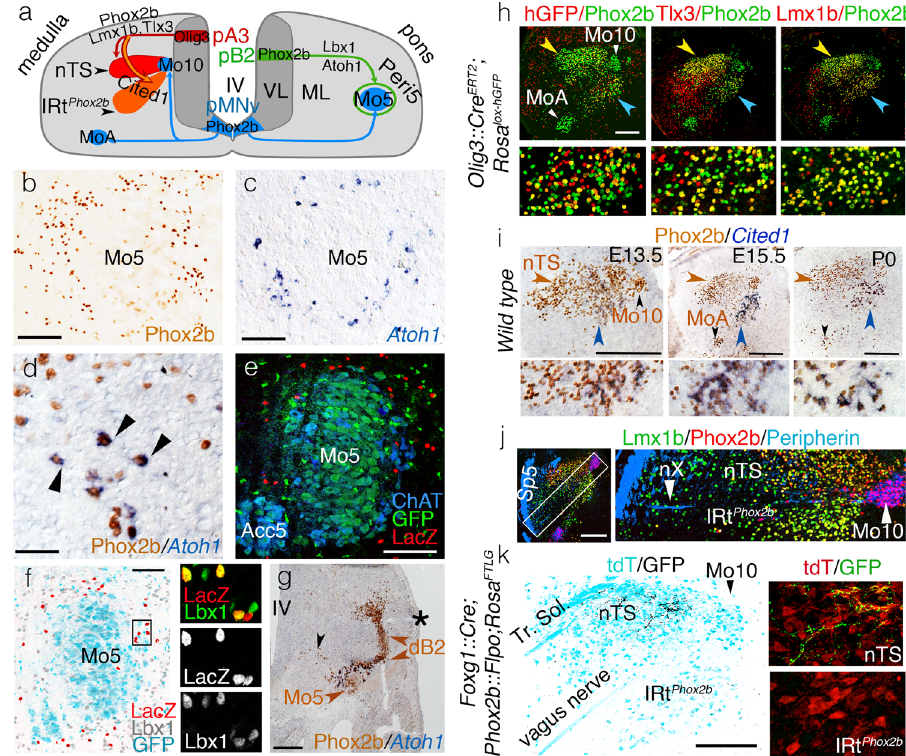
Fig. 2 Ontogenetic de fi nition of IRt Phox2b and Peri5 Atoh1 . a Two schematic hemisections of the embryonic medulla (left) or pons (right), showing the origin of branchiomotor nuclei (Mo5, MoA, and Mo10), Peri5 Phox2b and IRt Phox2b in progenitor (p) domains of the ventricular layer (VL), their settling sites in the mantle layer (ML), and their transcriptional codes. b – d Coronal sections through the pons at E18.5, showing Peri5 Phox2b ( b ) or Peri5 Atoh1 ( c , d ) labeled with the indicated antibody or probe. Peri5 Atoh1 cells co-express Phox2b and Atoh1 (arrowheads in d ). e Coronal sections through Mo5 in a Phox2b::Flpo;Atoh1::Cre ; Fela mouse at P0, showing the doubly recombined (nlsLacZ + ) cells of Peri5 Atoh1 (red). f Coronal section through Mo5 in a Phox2b::Flpo;Atoh1::Cre ; Fela mouse, where Phox2b + motoneurons are GFP + (cyan) and Phox2b + /Atoh1 + neurons are nlsLacZ + (red), counterstained for Lbx1 (gray at low magni fi cation, green in the close-ups). g Coronal section through the pons at E11.5 showing the migrating Phox2b + Mo5 and dB2 precursors (black and brown arrowheads, respectively) and, at their meeting point, Peri5 Atoh1 cells that have switched on Atoh1 . Asterisk: lateral recess of the IVth ventricle (IV). h Coronal sections through nTS (yellow arrowhead) and IRt Phox2b (blue arrowhead) at E18.5, at low magni fi cation (upper) or at high magni fi cation for the IRt (lower), stained with the indicated antibodies. A history of Olig3 expression is revealed by recombination of the histone-GFP ( hGFP ) reporter in the Olig3::Cre ERT2 background (left). Mosaicism is likely due to incomplete induction of Cre. Virtually all cells of IRt Phox2b (98%± 0.2 SEM, n = 3 animals) co-expressed Lmx1b with Phox2b . i Coronal sections through nTS (brown arrowhead) and IRt Phox2b (blue arrowhead) at indicated stages at low magni fi cation (upper) and high magni fi cation for the IRt (lower), immunostained for Phox2b and in situ hybridized for Cited1 . j Coronal section at E15.5 showing that nTS and IRt Phox2b are separated by the medullary root of the vagus nerve (nX). Sp5 spinal trigeminal tract. k Coronal section through the nTS and IRt Phox2b of an adult, showing the central boutons of epibranchial ganglia (that express Foxg1 72 and are labeled by SypGFP in a Foxg1 iresCre ; Phox2b::Flpo;Rosa FTLG background) in the nTS, but not IRt Phox2b (left). Magni fi ed details (right). Scale bars, b , c 125 μ m, d 50 μ m, e , f 100 μ m, g , h , j , k 200 μ m, and i , 250 μ